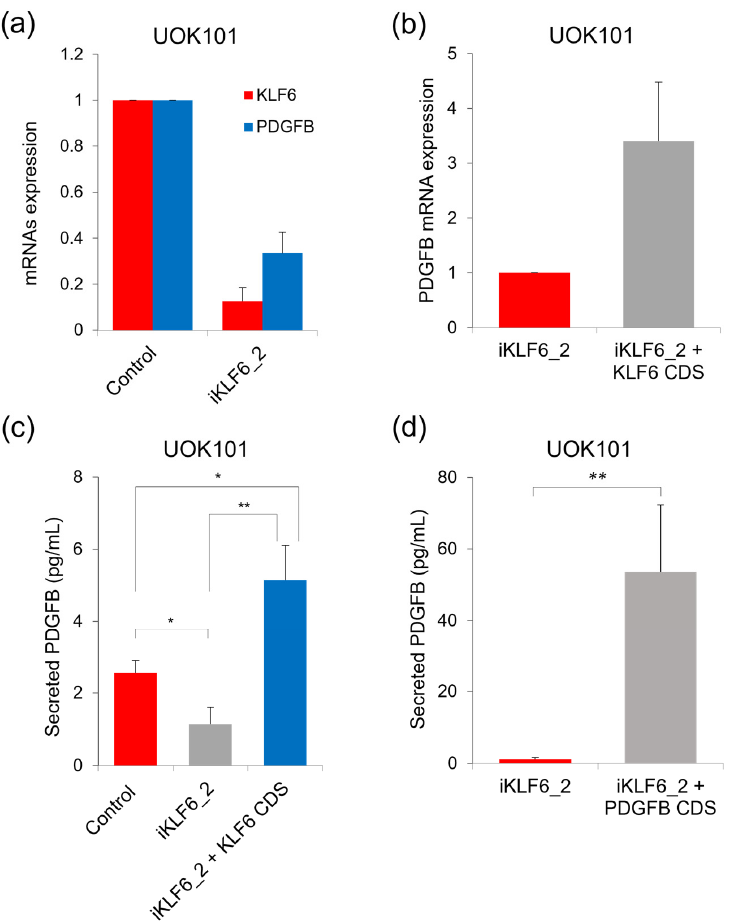
Figure 4. KLF6 modulates PDGFB expression and secretion in UOK101 cells. ( a ) The expression of KLF6 and PDGFB in the KLF6-repressed UOK101 cells. ( b ) The expression of PDGFB in the KLF6-repressed UOK101 cells that expressed exogenous KLF6 CDS. Average of two independent experiments. Error bars represent SD. ( c ) PDGFB secretion level in the UOK101 control cells, KLF6-repressed UOK101 cells, and KLF6-repressed UOK101 cells that were reintroduced with exogenous KLF6 CDS. Average of three independent experiments. Error bars represent SD. p -value by one-way Anova. ** p < 0.005, * p < 0.05. ( d ) The secreted PDGFB level upon the reintroduction of exogenous PDGFB CDS into the KLF6-repressed UOK101 cells. Average of three independent experiments. Error bars represent SD. p -value by two-tailed t -test. ** p < 0.005.